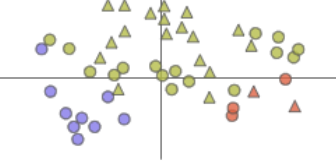
Figure 7. The AAFS Detailed Clustering View displays the clustering subspace of the AAFS Clustering View. Different colors represent different clusters. The triangles in the plot represent the mapping of cavity-lining amino acids, and the circles represent the mapping of other amino